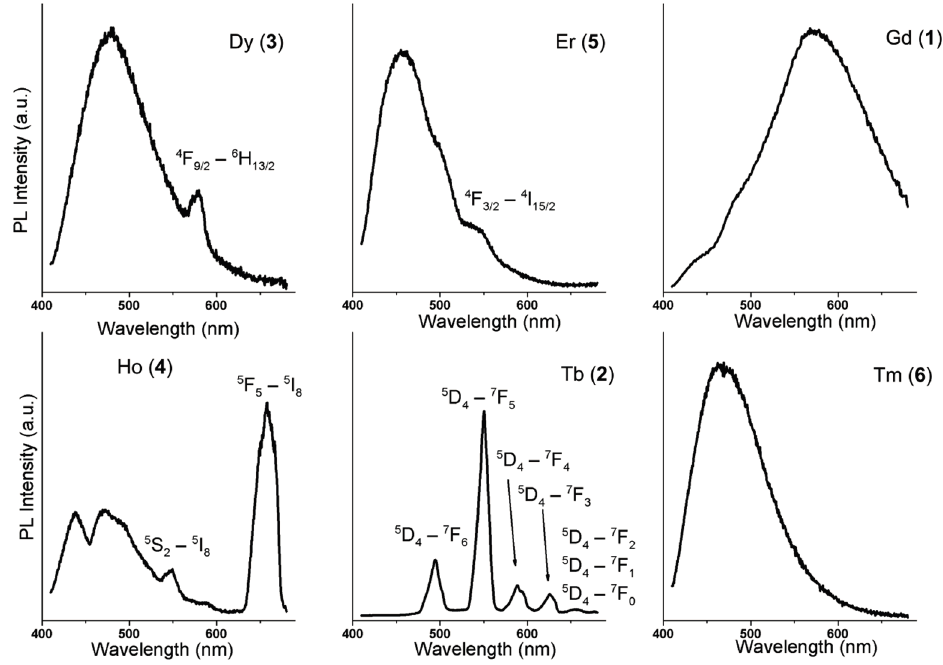
Figure 6. The emission spectra of the complexes 1 – 6 , λ ex = 350